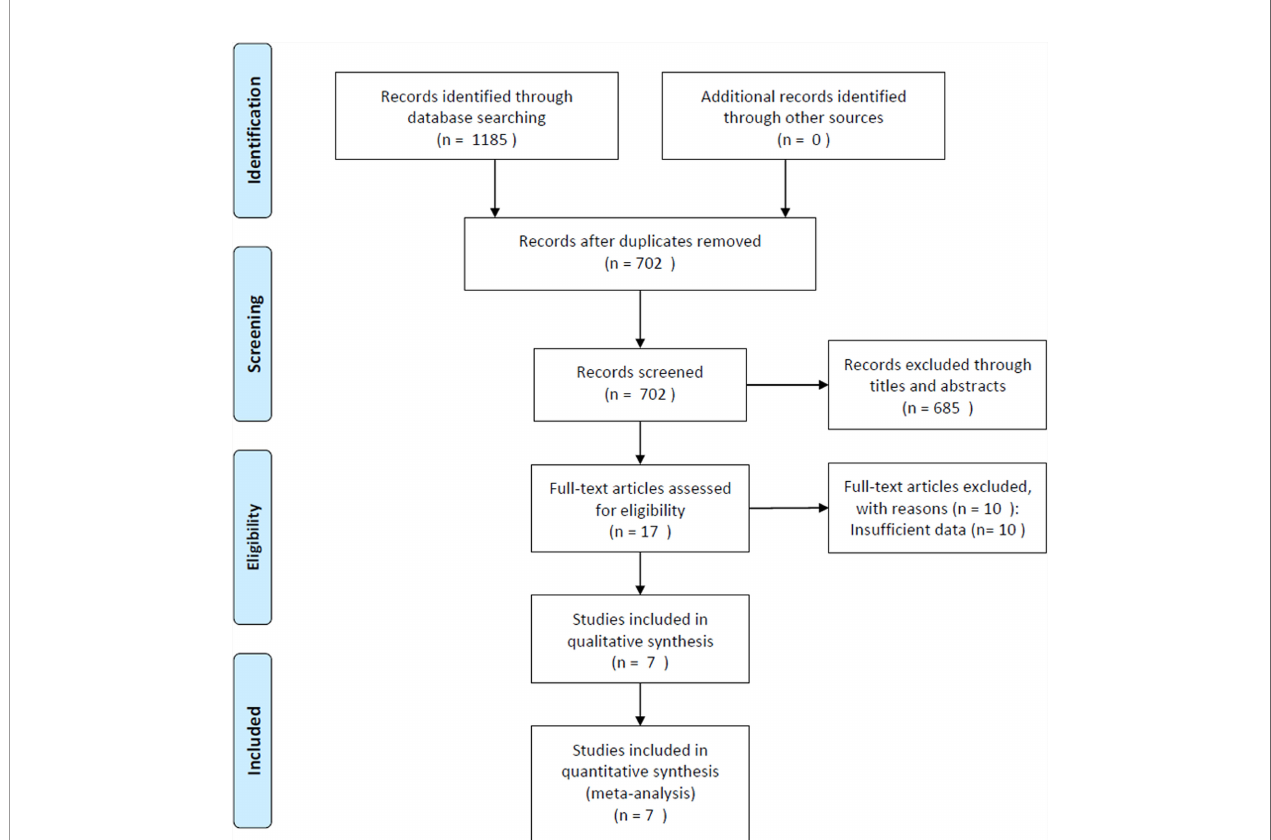
FIGURE 1 | Flowchart of study selection for inclusion in the